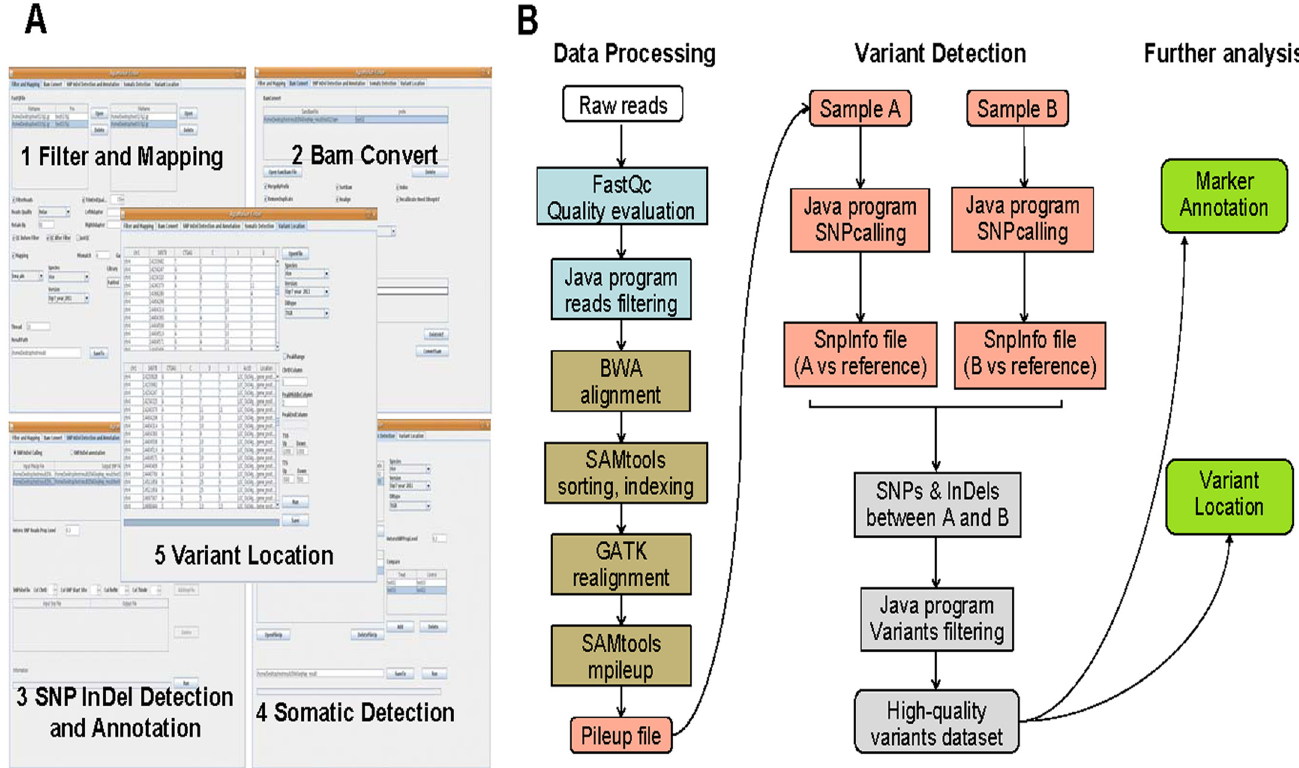
Fig 1. Development of AgroMarker Finder (AMF). (A) Graphical User Interface of AgroMarker Finder. (1) Filter and Mapping module for quality assessment, filtering and mapping of data. (2) Bam Convert module for manipulating alignments in BAM or SAM format, including merging, filtering multiple mapped reads, sorting, indexing, removing duplicates, realigning and recalibrating. (3) SNP InDel Detection and Annotation module for SNP/InDel calling and annotation. (4) Somatic Detection module for variant discovery between two samples. (5) Variant Location module for locating the region of mutation. (B) Analysis pipeline showing procedures for RAD-seq data processing based on AMF. Data processing (shown in dark grey) trims and filters raw reads to remove low-quality bases and reads. Quality of raw data and filtered data are evaluated by FastQC. Filtered data are aligned against a reference genome using BWA. Uniquely mapped reads are sorted and indexed by SAMtools. Afterwards data are realigned by GATK. Then, SAMtools is used to generate pileup format files for each sample (in yellow). These pileup files are input for variant detection and filtering (in orange and grey) using the Java program with optional parameters. High-quality markers are annotated and located to linked genes (in blue) based on the Java